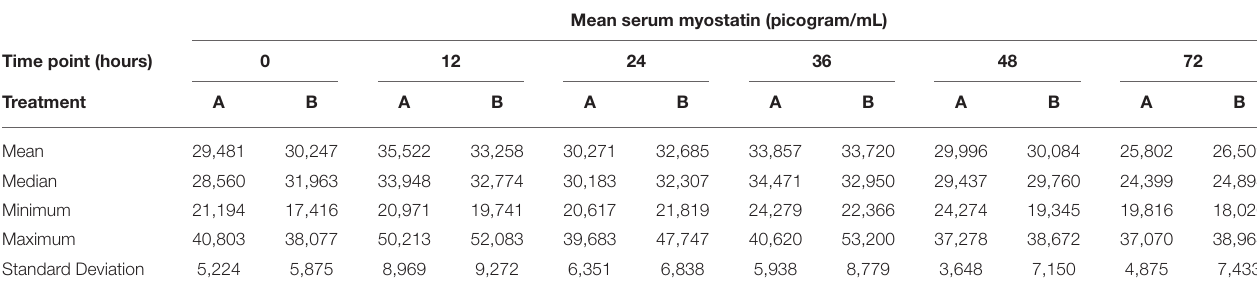
TABLE 3 | Phase 1: Low dose Fortetropin (6g) vs. Placebo: Mean, median, minimum, and maximum serum myostatin concentrations (pg/mL) and corresponding standard deviation.